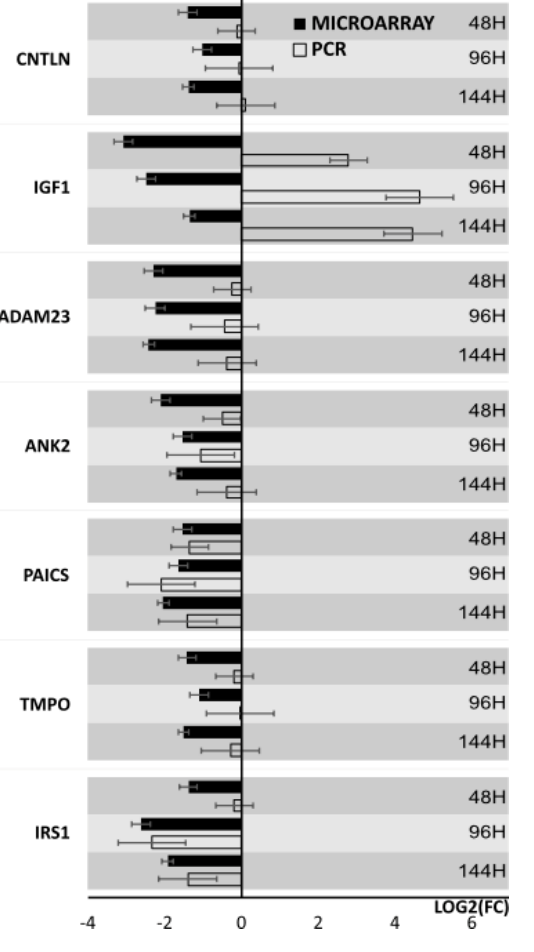
Figure 9. Bar graph showing validation results of microarrays of downregulated genes obtained by RT-qPCR.